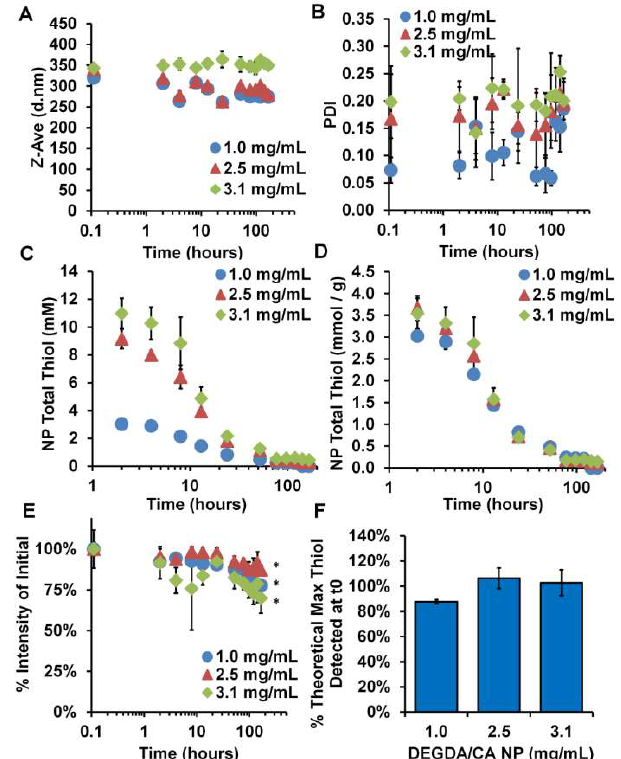
Figure 5. Size and activity kinetics of DEGDA/CA nanoparticles in PBS/PVA/EDTA. ( A ) z -average diameter, ( B ) polydispersity index, ( C ) total thiol found, ( D ) total thiol found per mass of nanoparticles, ( E ) % intensity of dispersion over time, and ( F ) % of the theoretical maximum thiol concentration found after washing. n = 3, M ± SD. * Indicates p < 0.05 intensity change from original.